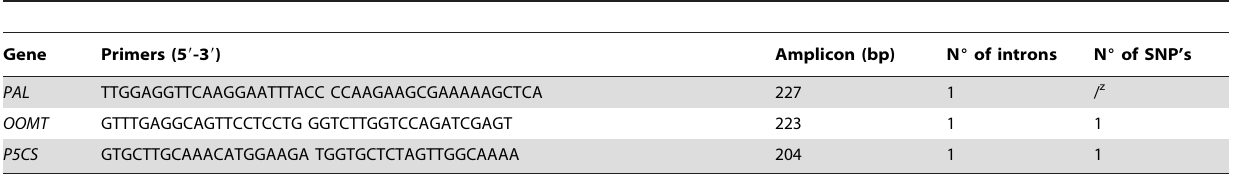
Table 2. Overview of HRM primers for PAL (Phenylalanine Ammonia Lyase), OOMT (Orcinol O-Methyl Transferase) and P5CS (Pyrroline-5-Carboxylate